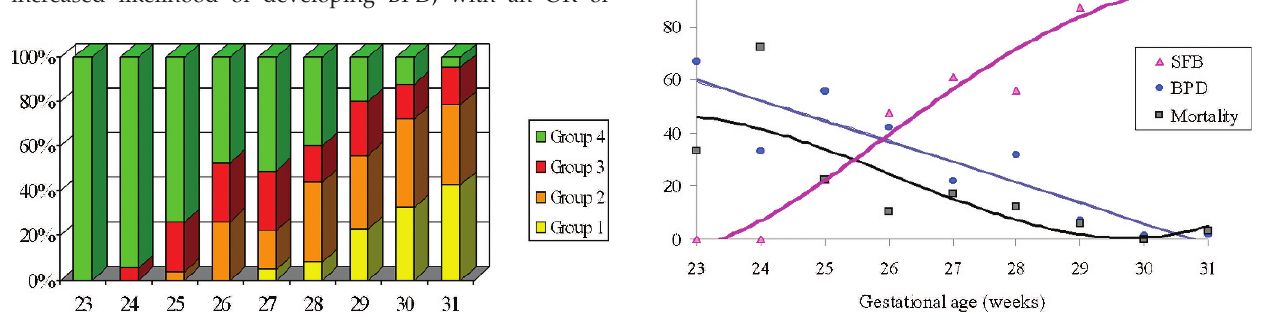
Figure 1 - Respiratory support by GA (weeks). Figure 2 - Survival free of BPD (%) by